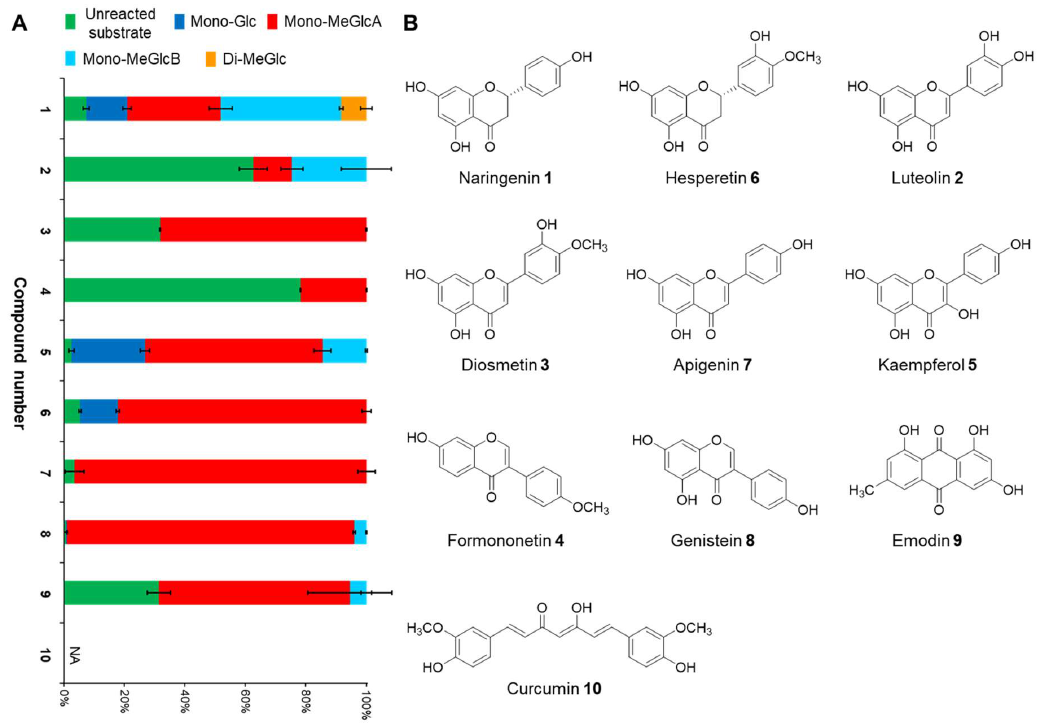
Figure 2. The biotransformation of phenolic substrates by I. fumosorosea ACCC 37814. ( A ) Total conversion rate [%] of each tested substrate. All data represent the means ± SDs in three independent experiments. Mono-Glc: mono-glucoside; Mono-MeGlcA and –B: mono-(4- O -methyl)glucoside regioisomers; Di-MeGlc: di-(4- O -methyl)glucoside. NA: not applicable ( B ) Chemical structures of substrates 1 – 10 . See Supplementary Materials, Table S1 for tabulated data.